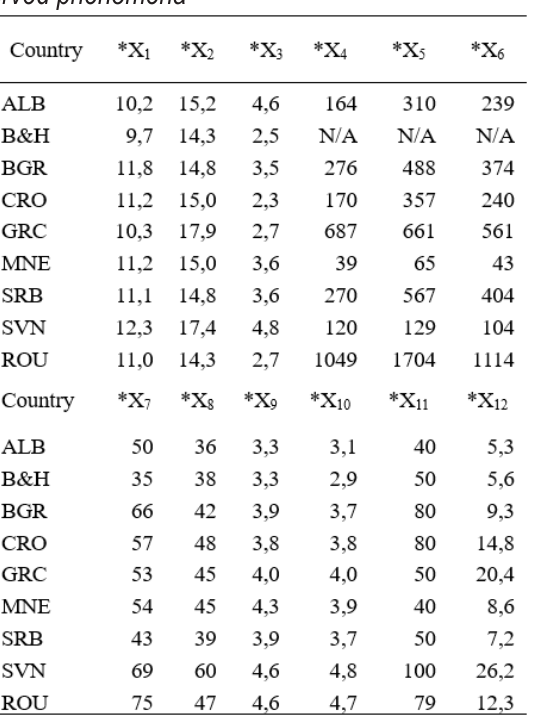
Data for the analysis of observed